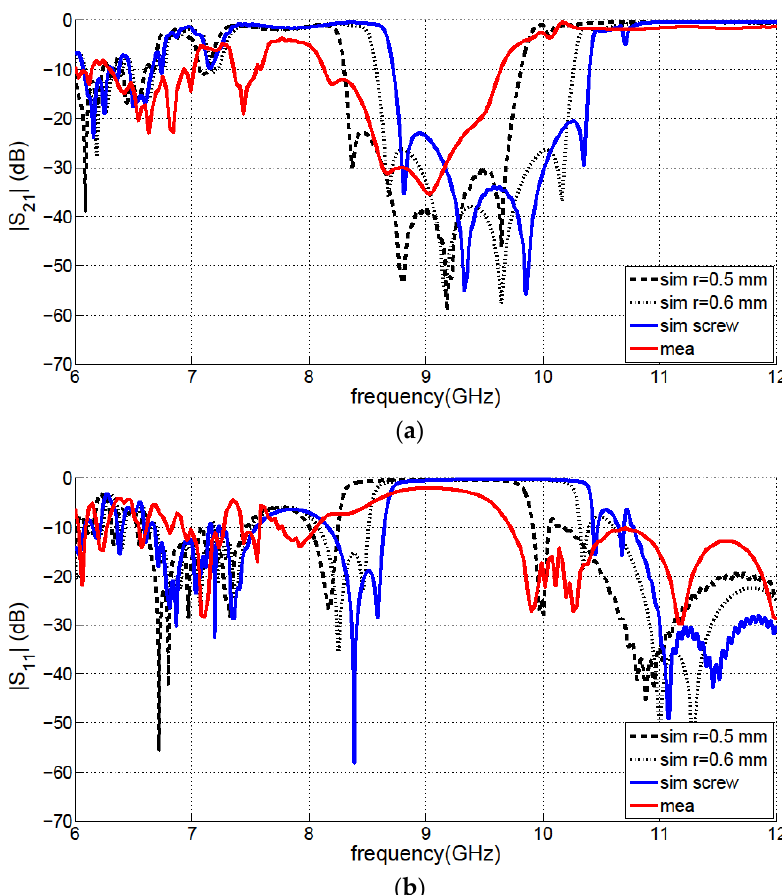
Figure 17. Measured (with M1.4 metric screw) and simulated results for the proposed EBG filter (with via of radius r = 0.6 mm and r = 0.5 mm and for the screw model re = 0.7 mm and ri = 0.65 mm) for 5-cell EBG filter: ( a ) S21 ( b ) S11.